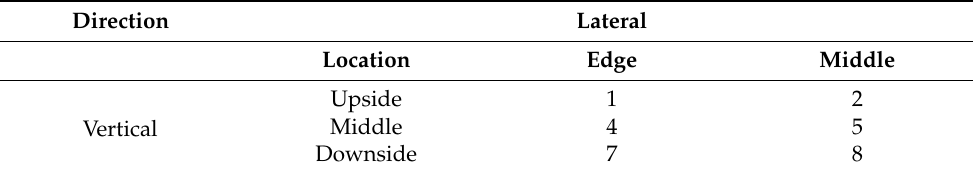
Table 6. The calculating strategy of CaCO 3 distribution characteristic.